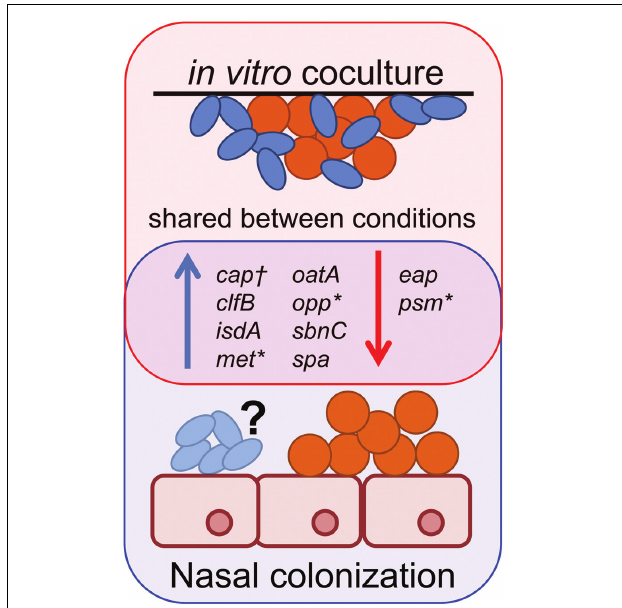
FIGURE 7 | Staphylococcus aureus gene expression during in vivo colonization is similar to in vitro coculture with C. striatum . Gene expression data from S. aureus (orange spheres) in vivo colonization of humans (Burian et al., 2010b; Krismer et al., 2014), cotton rats (Burian et al., 2010a) or in vitro coculture with C. striatum (blue ovals) ( Table 1 /Supplementary Table S1) is depicted as upregulated (blue arrows) or downregulated (red arrows) in comparison to in vitro monoculture. Genes quantified by qRT-PCR in vivo share similar patterns of expression with those detected with RNAseq during in vitro coculture with C. striatum (“shared between conditions”). ∗ In several cases, individual genes identified by qRT-PCR were part of operons whose members were also differentially regulated in our RNASeq results (Supplementary Table S1). † Type 5 capsule (CP5) production was quantified by ELISA in a mouse nasal colonization model (Kiser et al., 1999) and was overrepresented in vivo versus in vitro . We observed upregulation of several CP5 synthesis genes in coculture with C. striatum (Supplementary Table S1). It is unknown (“?”) whether or not Corynebacterium spp. were present in the referenced in vivo experiments. These data demonstrate the similarities in S. aureus gene expression during host commensal in vivo colonization and in vitro growth with Corynebacterium